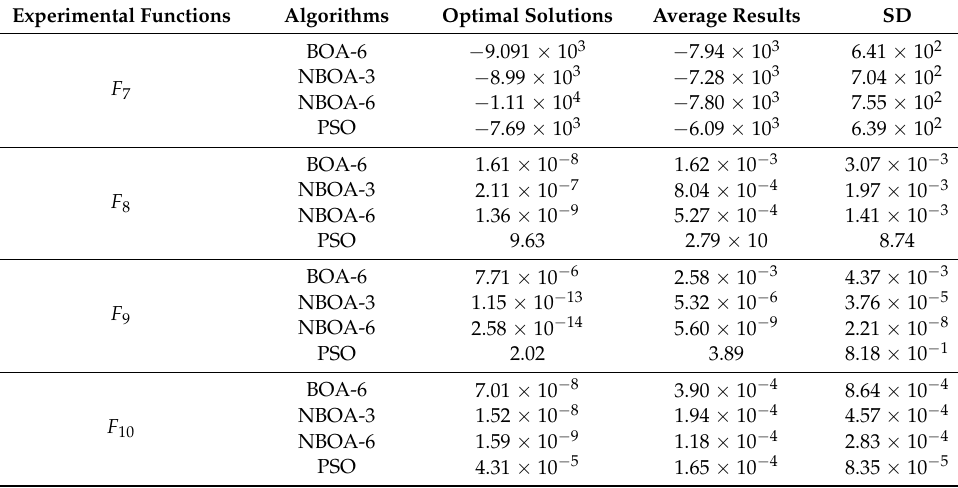
Table 8. Experimental results of multimodal function